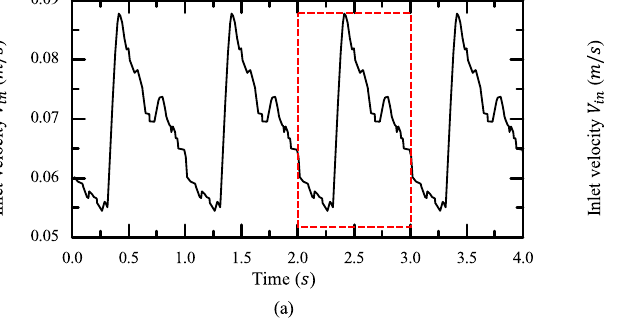
Fig. 12 The velocity profiles imposed on the artery inlets